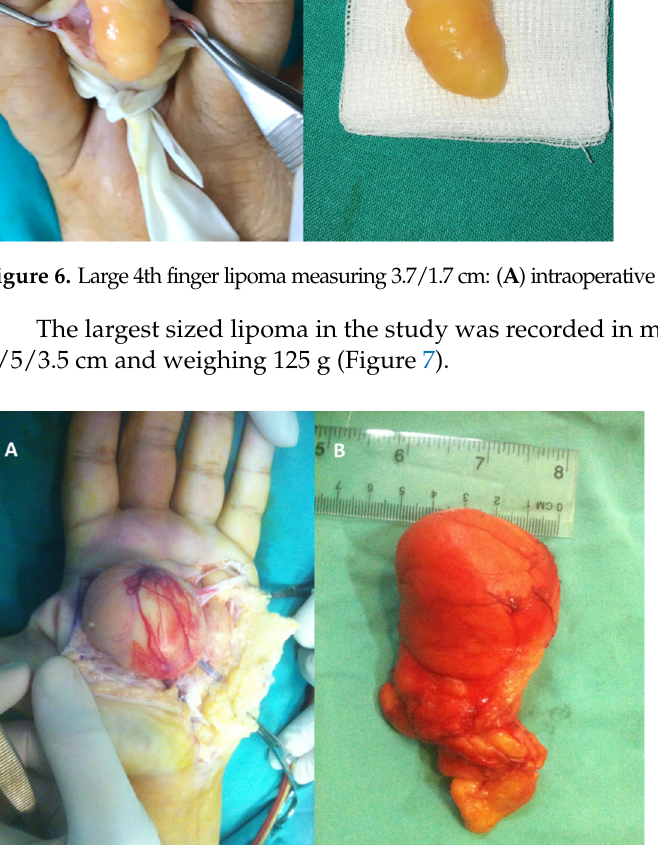
Figure 7. ( A ) Intraoperative aspects of a giant deep mid-palmar lipoma extended to thenar and hipothenar eminences—the thenar segment of lipoma was first approached and a tumor was located under the teguments, wrapped in a thin, well-vascularized fibrous capsule. During dissection, the tumor was found to be located under the palmar vascular arch and under common digital nerves, which were elongated; the incision was extended and the smaller portion of the tumor, located at the cubital hemihand, was approached, dissecting the tumor of tendinous adhesions. The 5th deep flexor tendon was found torn. Finally, the tumor was passed under the palmar vascular arch and extracted with the thenar segment through the first incision. ( B ) Removed specimen.